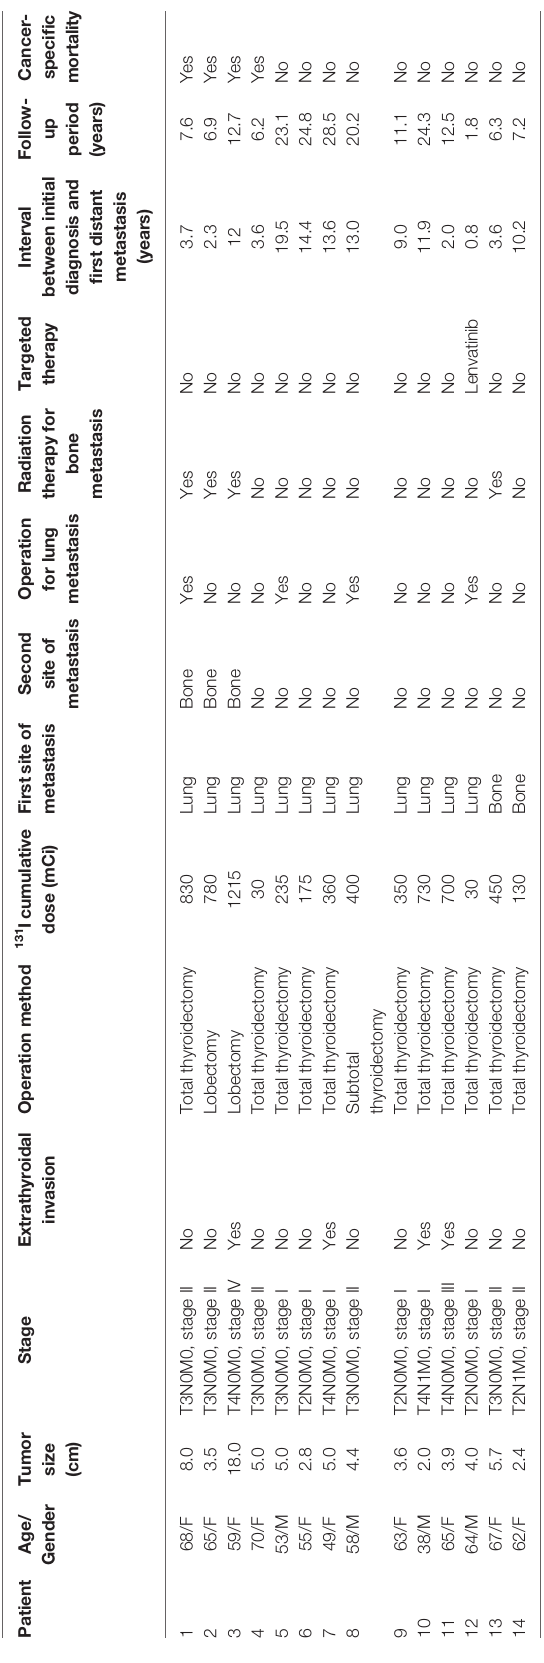
TABLE 5 | Risk factors associated with mortality in 14 patients who developed metastasis during follow-up.